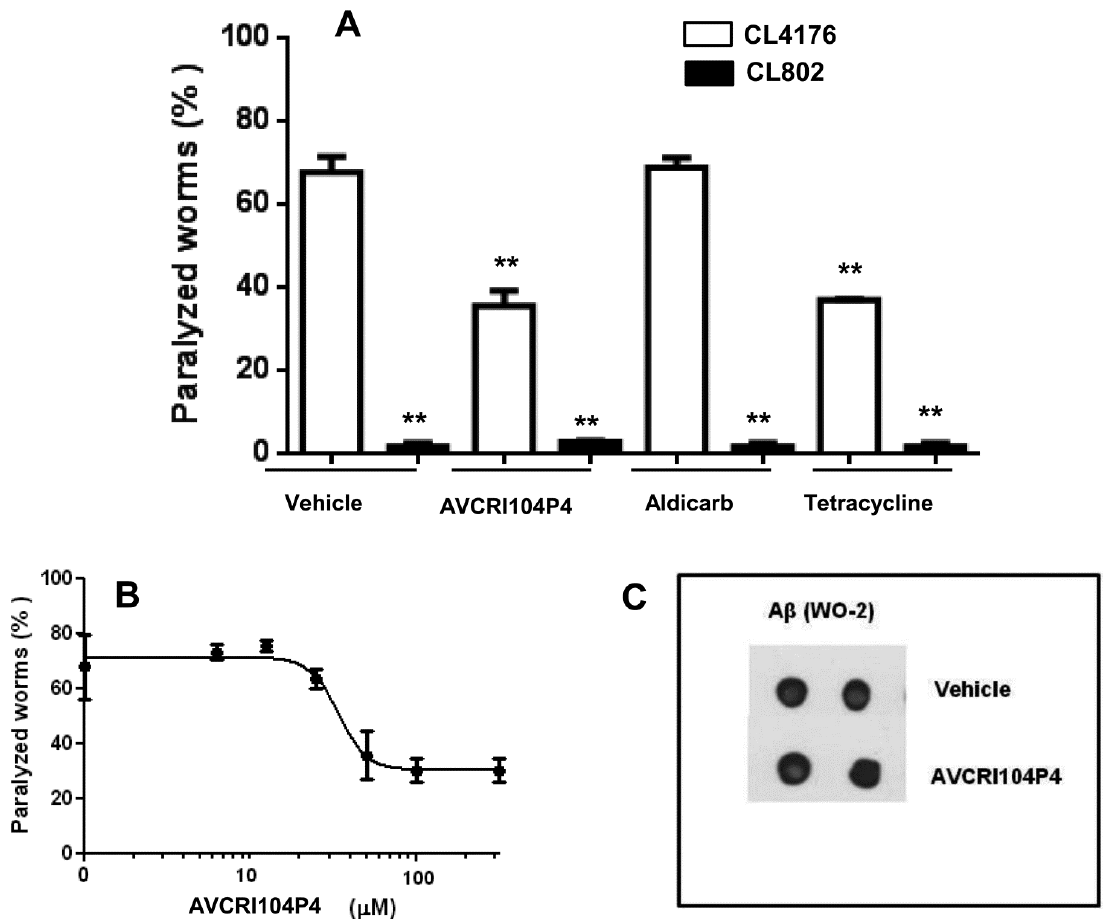
Figure 3. Effect of AVCRI104P4 on the paralysis of CL4176 worms. ( A ) Percentage of paralyzed CL4176 and CL802 worms fed with 100 µM AVCRI104P4, 100 µM aldicarb, or 100 µM tetracycline 18 h after the temperature increase. Paralysis was evaluated 42 h after the temperature rise. Data from three independent experiments ( n = 100, per group) are indicated as % ± S.D. of paralyzed nematodes to worms treated with vehicle. ** p < 0.01 vs. vehicle-treated CL4176 nematodes (One-way ANOVA test); ( B )